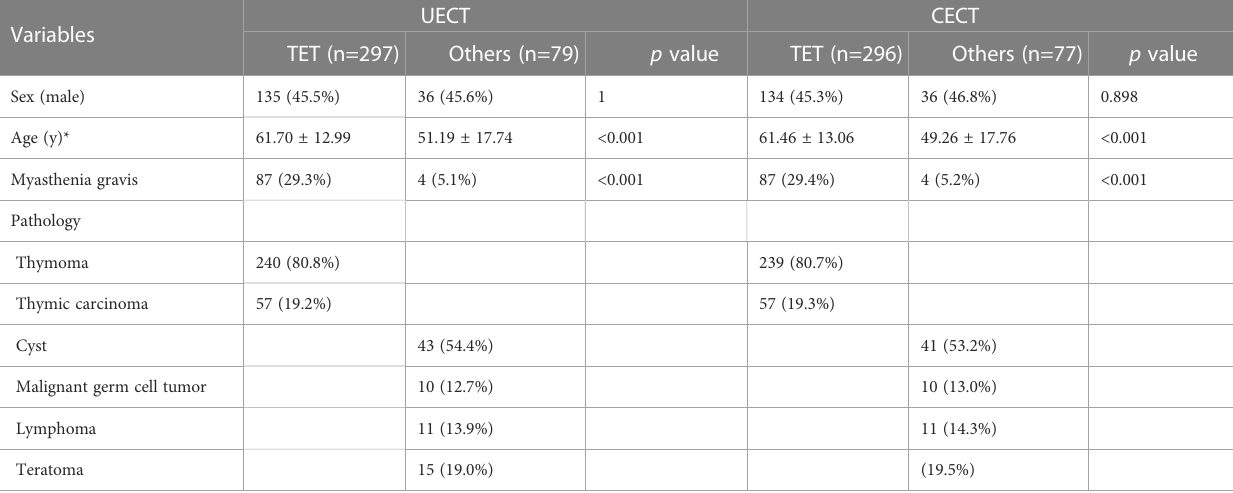
TABLE 1 Baseline characteristics of patients included for analysis.